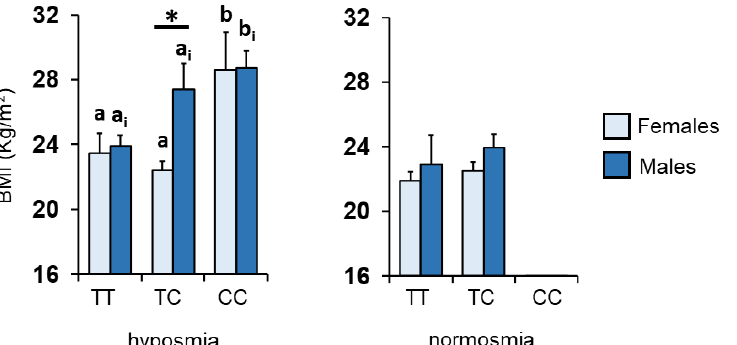
Figure 4. Mean (± SE) values of the BMIs determined in females and males according to their TDI